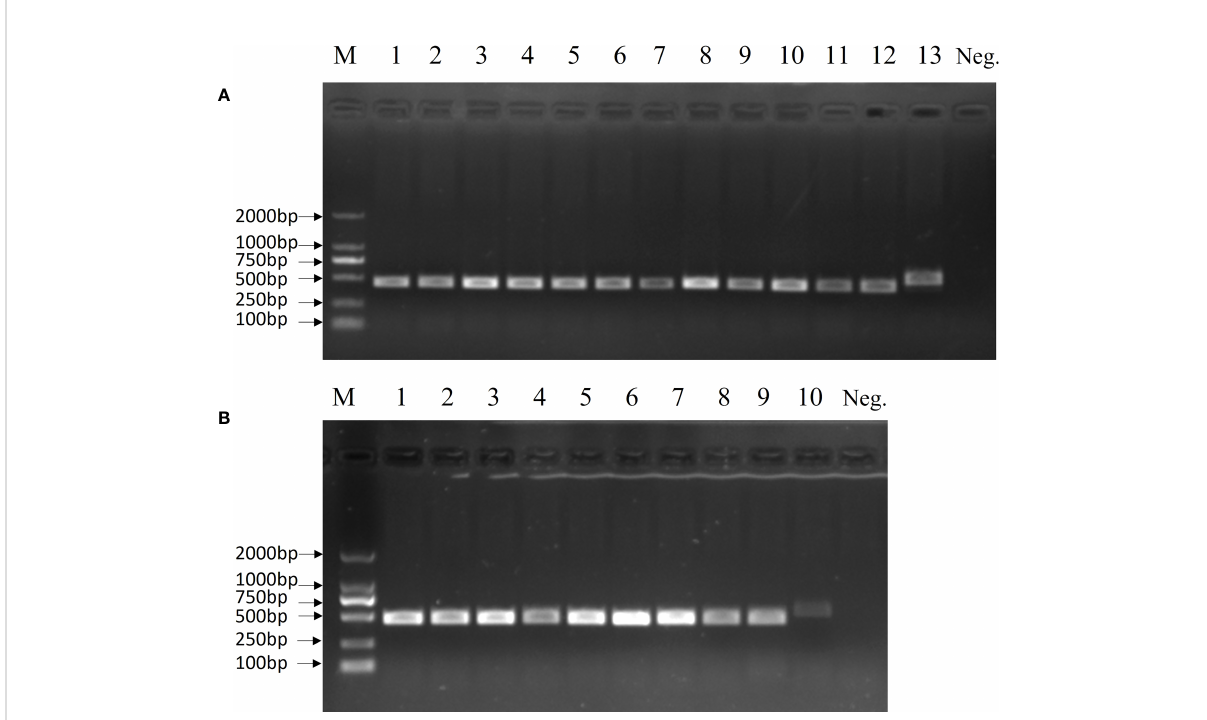
FIGURE 6 Multiplex PCRresults for 19clinical samples. (A) Lane M, DL-2000 DNA marker; Lanes1 – 11: Clinical strains; Lane 12: Streptococcus suis serotype 2; Lane 13, Streptococcus suis serotype 14; Neg.,Negative control. (B) Lane M,DL-2000 DNA marker;Lanes 1 – 8: Clinical strains; Lane 9: Streptococcus suis serotype 2; Lane 10: Streptococcus suis serotype 14; Neg.,Negative